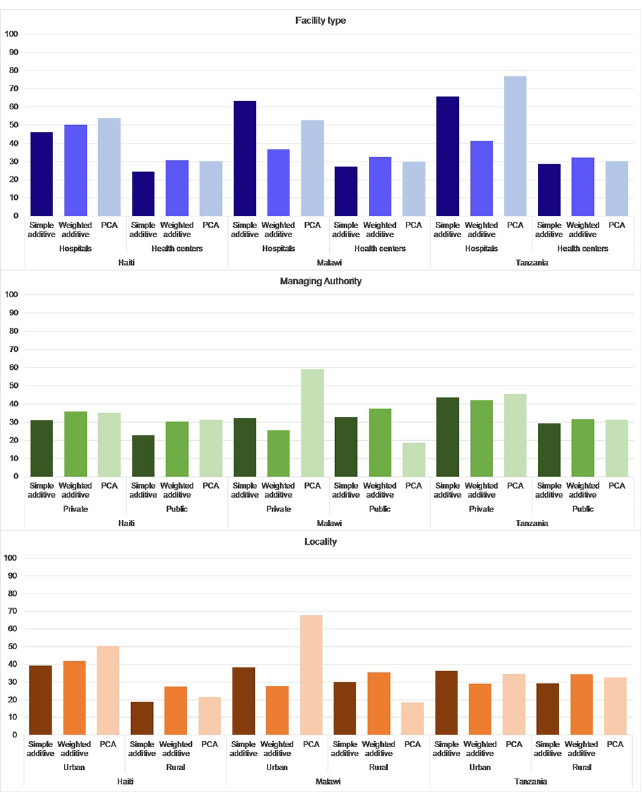
Fig 3. Percent of facilities scored as high quality by scoring mechanism and background